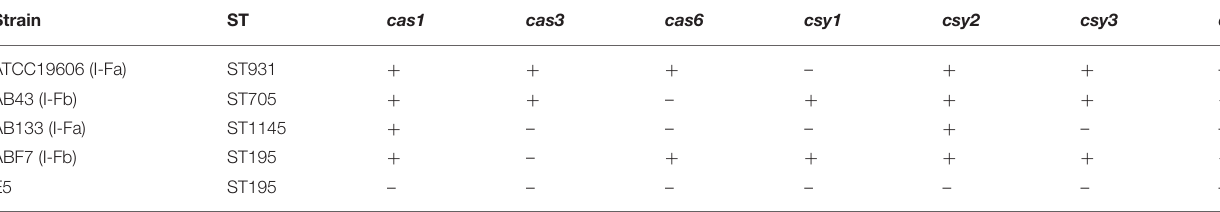
TABLE 2 | Strains with different carrying situations of CRISPR-Cas system genes.